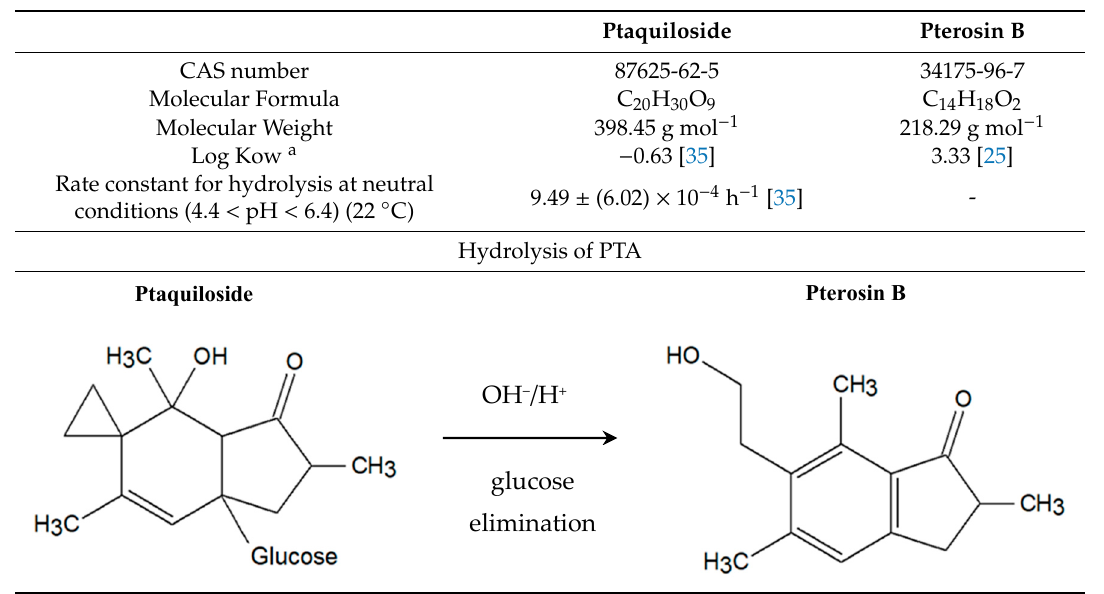
Table 1. Physicochemical properties of ptaquiloside and pterosin B.